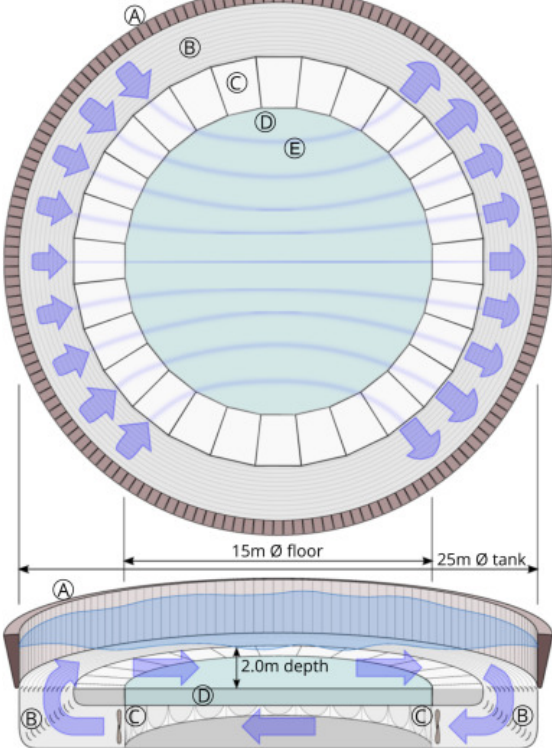
Figure 3. Schematic of the F LO W AVE circular combined wave and current test tank at Edinburgh,